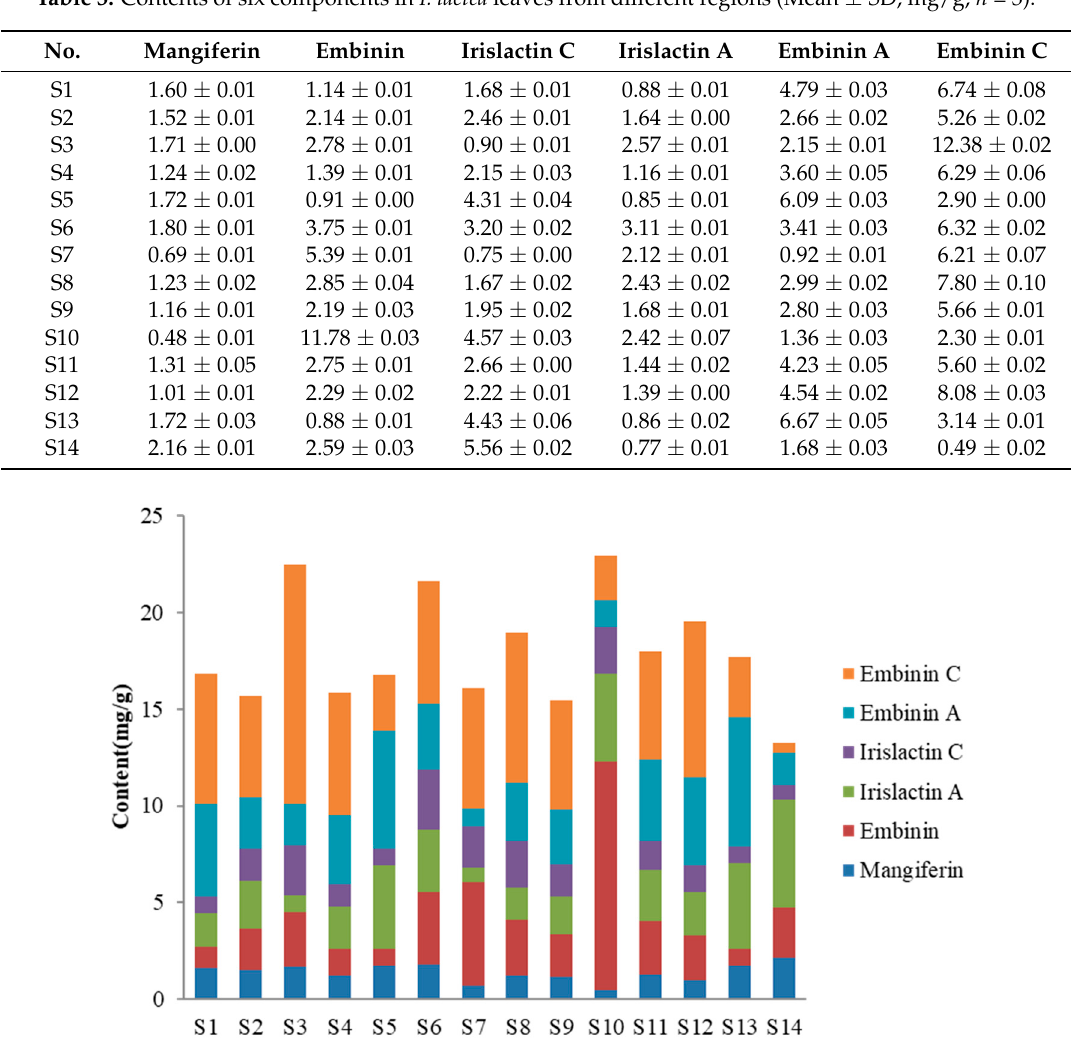
Figure 2. Total contents of main components in Iris lactea leaves from different Figure 2 . Total contents of main components in Iris lactea leaves from different areas.